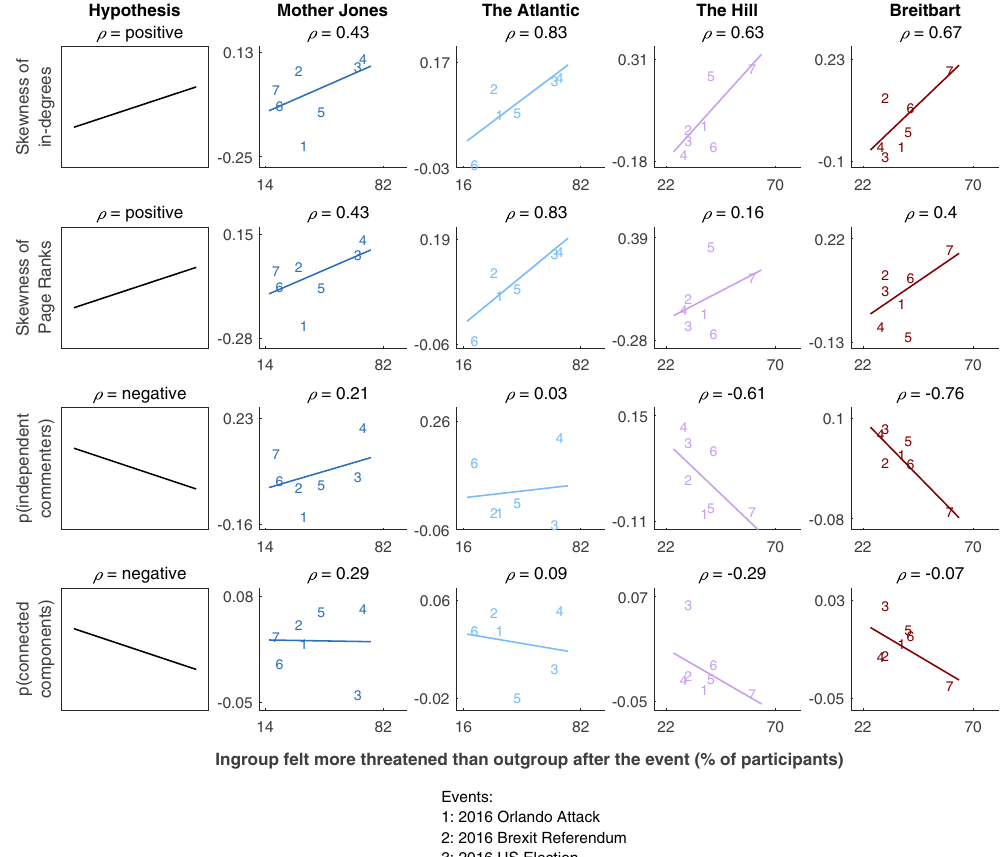
Figure 1. Changes in network measures of inequality of attention from before to after events rated as more or less threatening to the ingroups on different news sites. The ratings (x-axis) are summarized as the percentage of participants who estimated that the ingroup on a given site (Democrats for Mother Jones and The Atlantic, Republicans for The Hill and Breitbart) felt more threatened by the event than the outgroup (see “Method” for question texts). Rows show results for different measures of inequality of attention (y-axis) on the individual level (the first two rows) and the network level (the second two rows). The first column shows the hypothesized patterns of results, and the other columns show results for different sites. Numbers correspond to different events (see legend), and patterns are summarized by least-squares fitted lines across events and the Spearman ρ correlation coefficient above each plot. Colors denote the political orientation of different news sites: dark blue for the leftmost, Mother Jones, lighter blue for left-leaning The Atlantic, purple for the moderate to right, The Hill, and red for the rightmost,